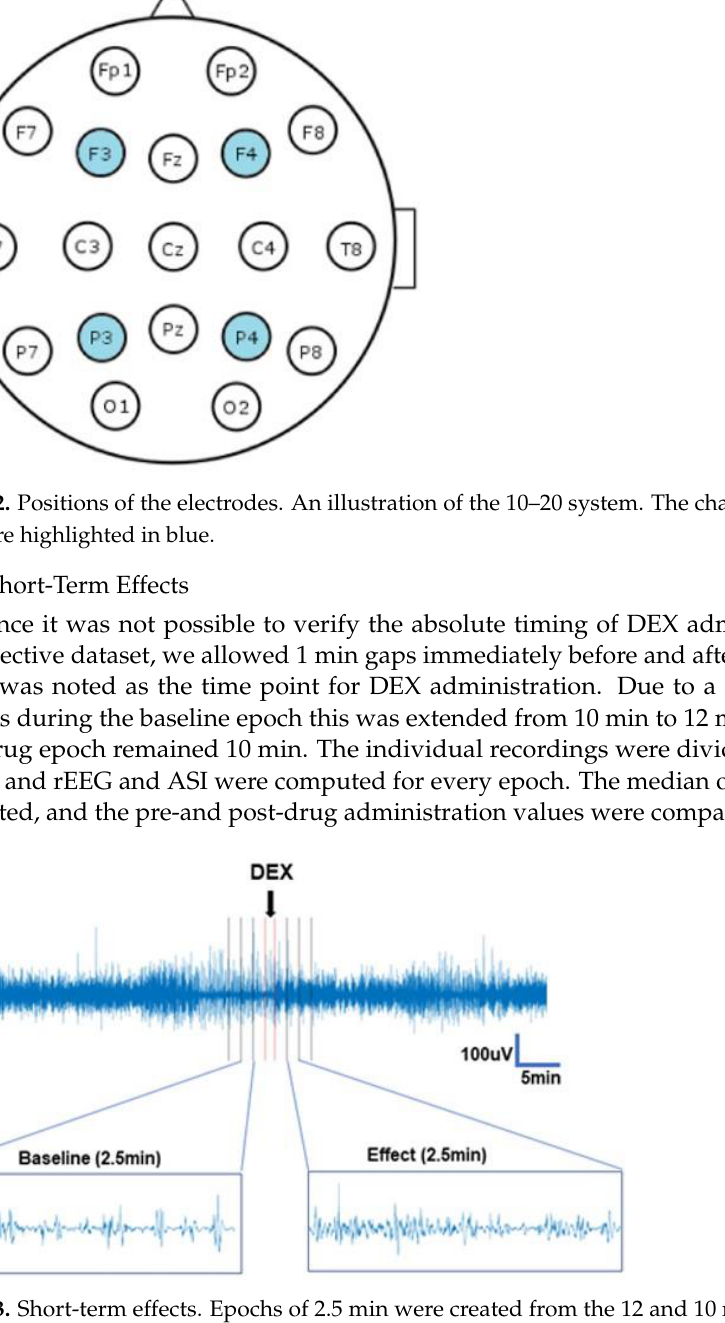
Table 1. Demograhics.